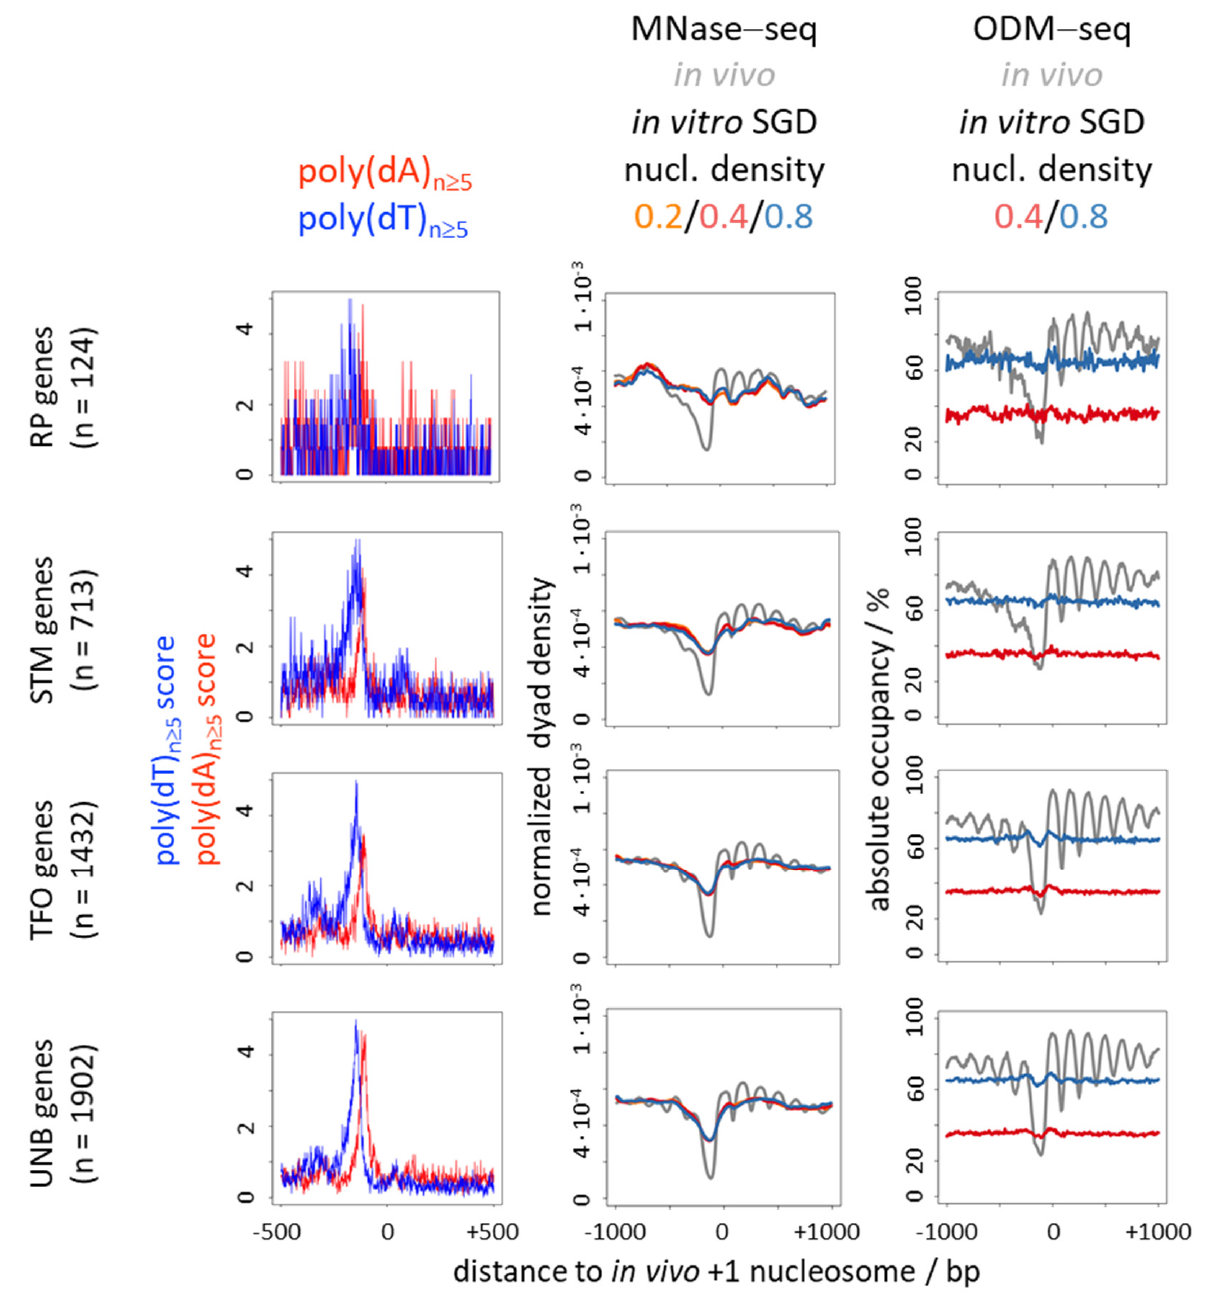
Figure 2. Alternative visualization of the strand bias of poly(dA) versus poly(dT) distribution in promoter regions as well as of the much less pronounced intrinsic nucleosome depletion over promoter regions in vitro compared to in vivo if monitored by ODM-seq versus MNase-seq. Relative nucleosome depletion does not depend on nucleosome density in in vitro reconstituted SGD chromatin. Composite plots of the same data as in Figure 1, and in addition of MNase-seq data from [33] of in vitro SGD chromatin with nucleosome density 0.2 and 0.4 (GSM4175428, GSM4175429, respectively) and of ODM-seq data from [17] of in vitro SGD chromatin with nucleosome density 0.4 (GSM4193222). Poly(dA)/poly(dT) scores correspond to the percentage of promoters in each group that have at the respective position along the x-axis a center of a homopolymeric poly(dA)/poly(dT) 5 bp window. Note that this gives an accurate distribution of poly(dA)/poly(dT) tracts, but underrepresents the number of bp within tracts as the outermost 2 bp flanking each tract are not